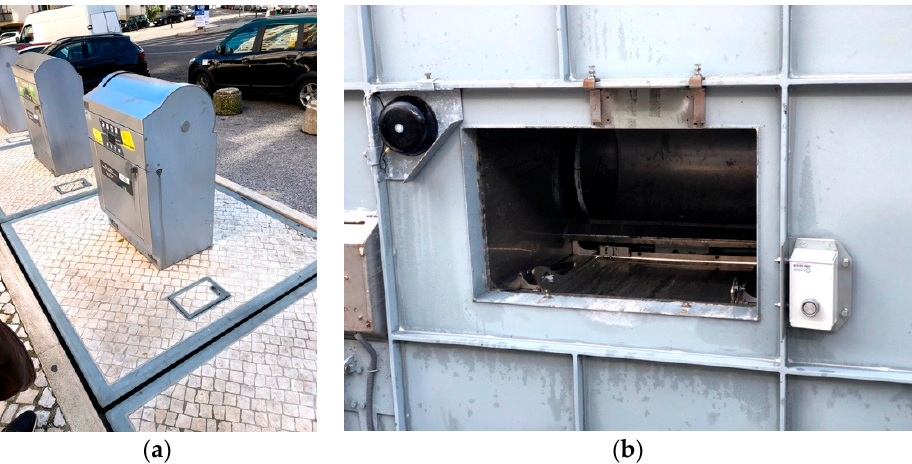
Figure 8. IoTsens installed on the underground waste bin: ( a ) general view; ( b ) cover underside view.